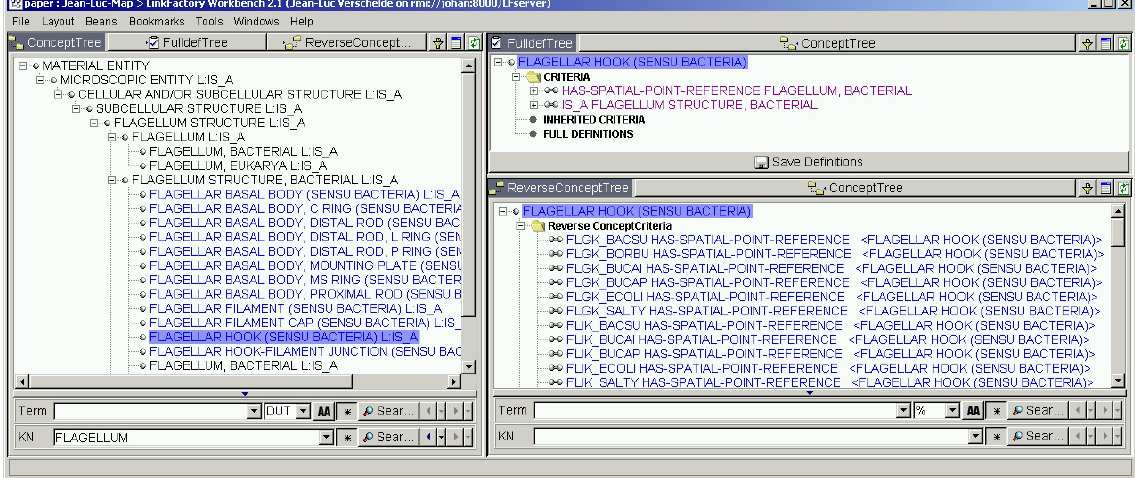
Figure 4 Representation of <flagellum> and its